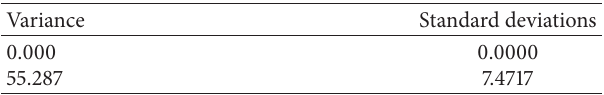
Table 7: The variances and standard deviations for random-effects model.